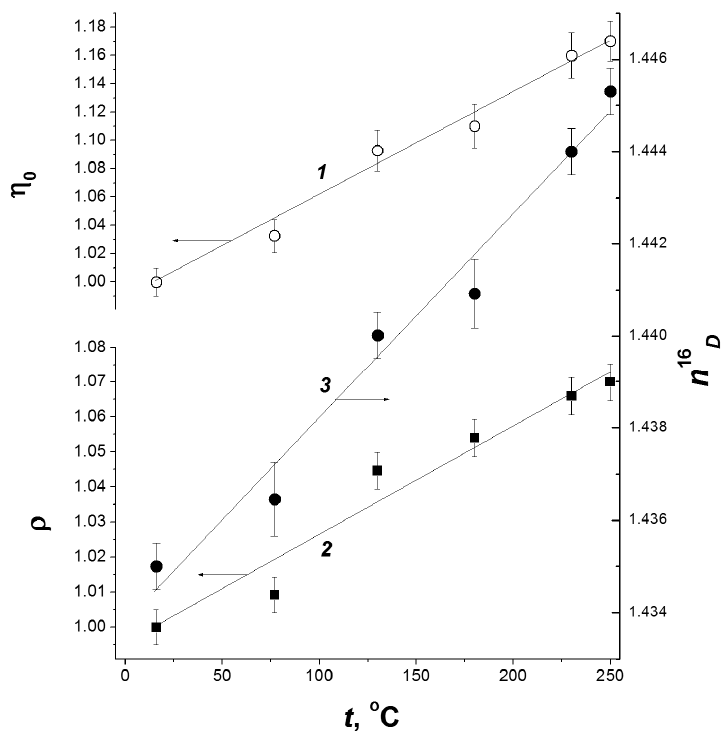
Figure 12. The effect of the starting temperature of radiolysis of C2 samples ( Z = 104 cm 2 /g) on the density ( 1 ), viscosity ( 2 ) and refractive index ( 3 ) of condensates